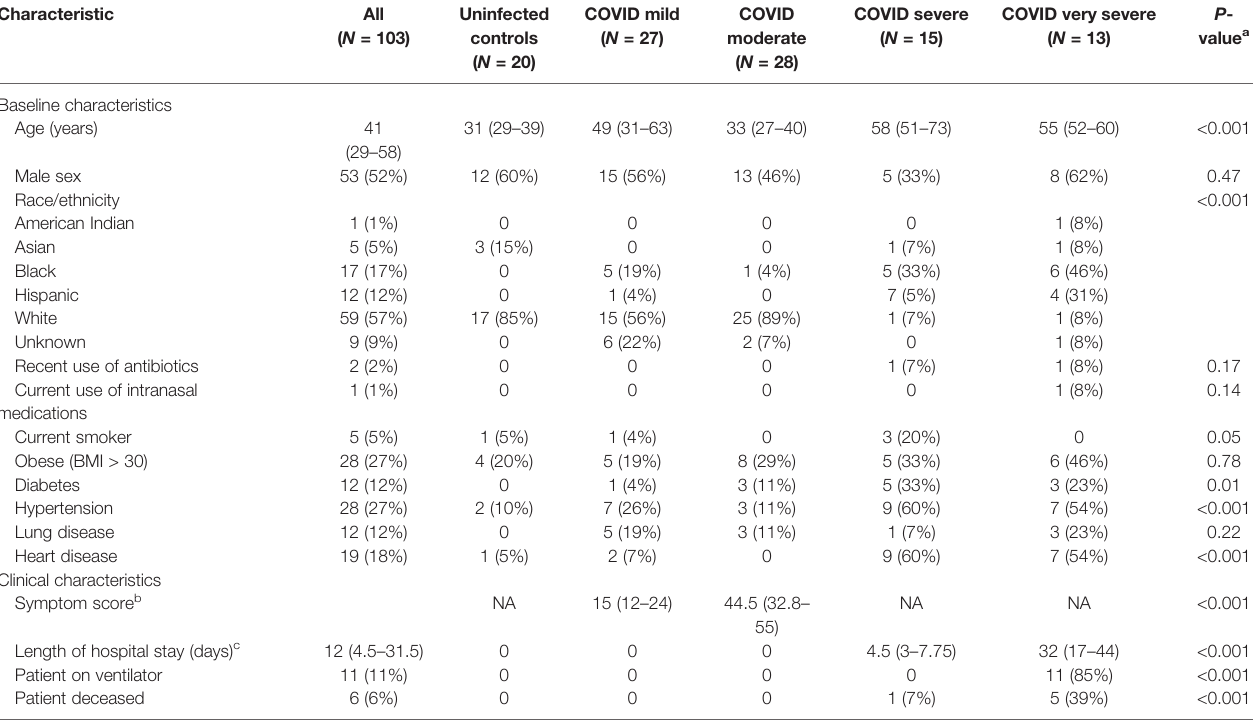
TABLE 1 | Baseline and clinical characteristics of SARS-CoV-2 uninfected controls and infected study participants included in the analysis.